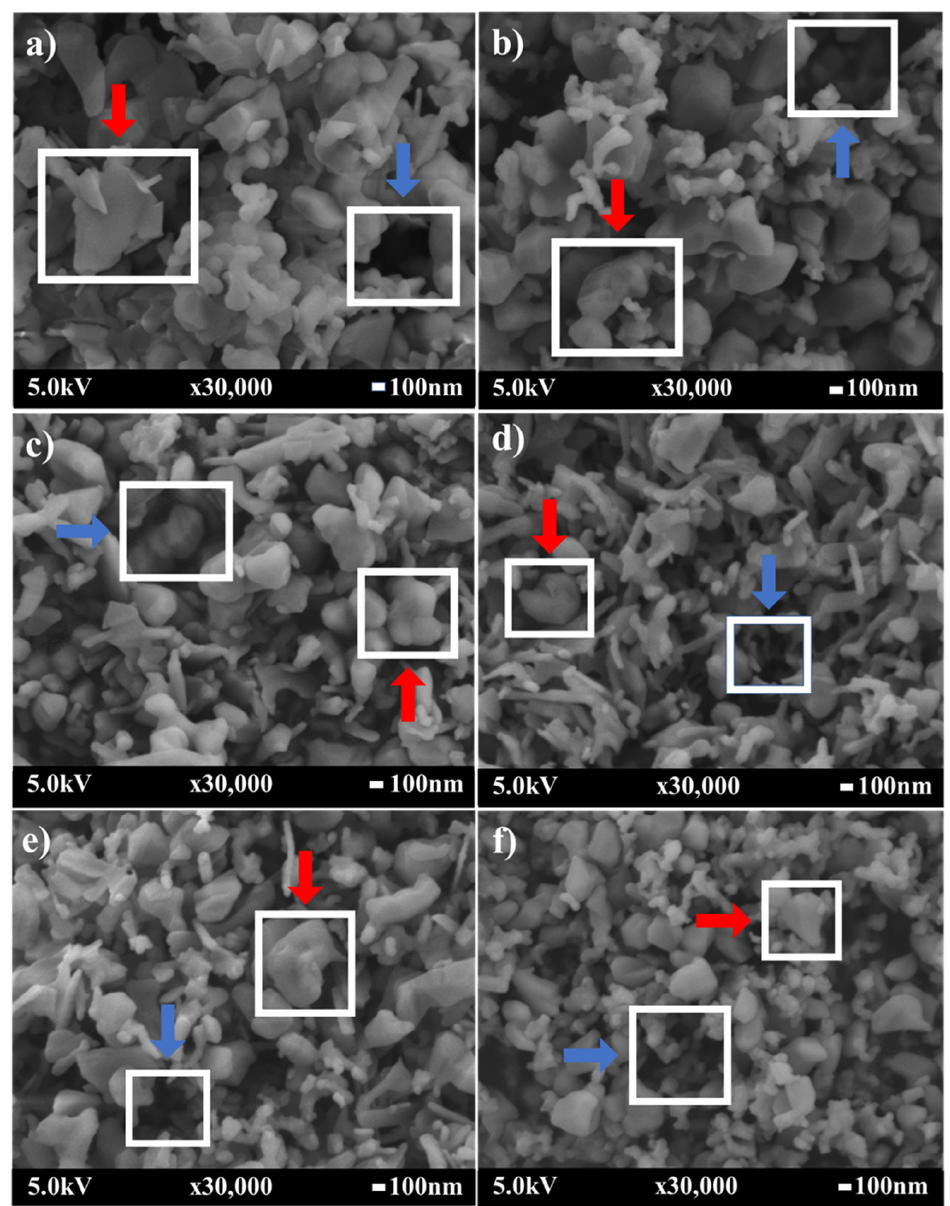
Figure 4. Morphological properties of biphasic calcium phosphate prepared by cuttlebone with variation of the CMC of L-rhamnose monohydrate biosurfactant: ( a ) no CMC, ( b ) 10 CMC, ( c ) 20 CMC, ( d ) 100 CMC, ( e ) 500 CMC and ( f ) 1000 CMC. ( d ) 100 CMC, ( e ) 500 CMC and ( f ) 1000